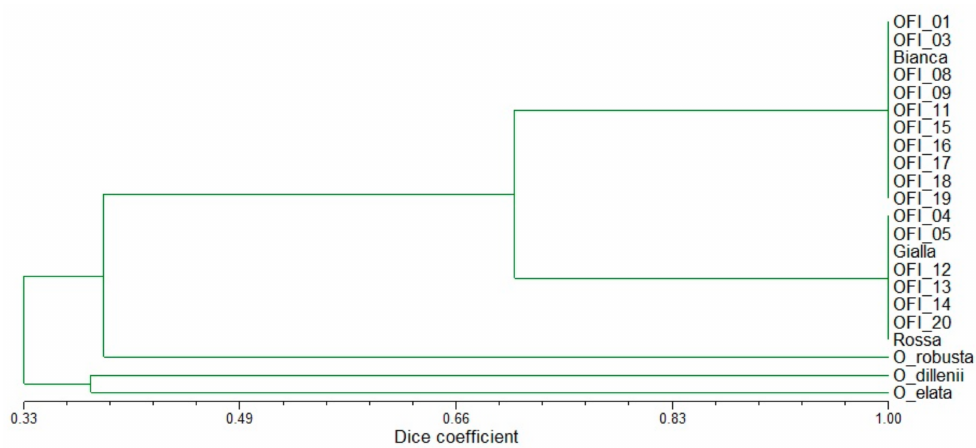
Figure 1. Dendrogram of the 22 Opuntia spp. populations obtained from SSR markers based on Dice coefficient and using the unweighted pair group arithmetic mean method (UPGMA) as the clustering method.